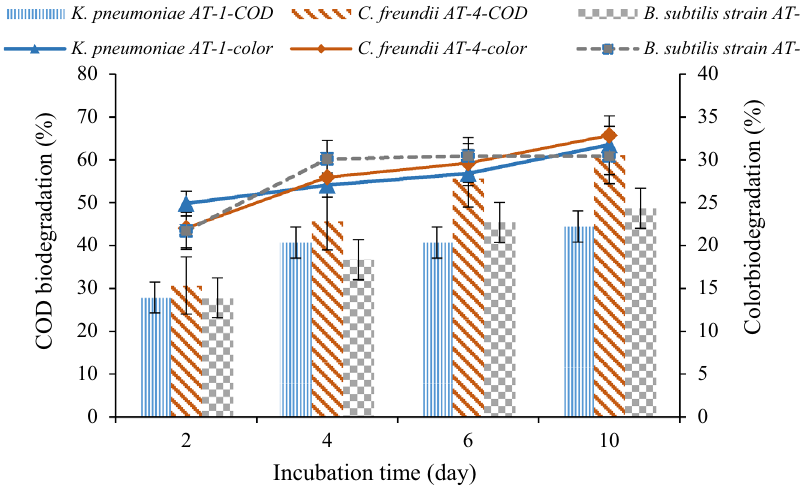
Figure 7. COD and color biodegradation rate by K. pneumoniae AT-1, C. freundii AT-4, and B. subtilis AT-5 in different incubation periods (effluent + culture + mineral salt).